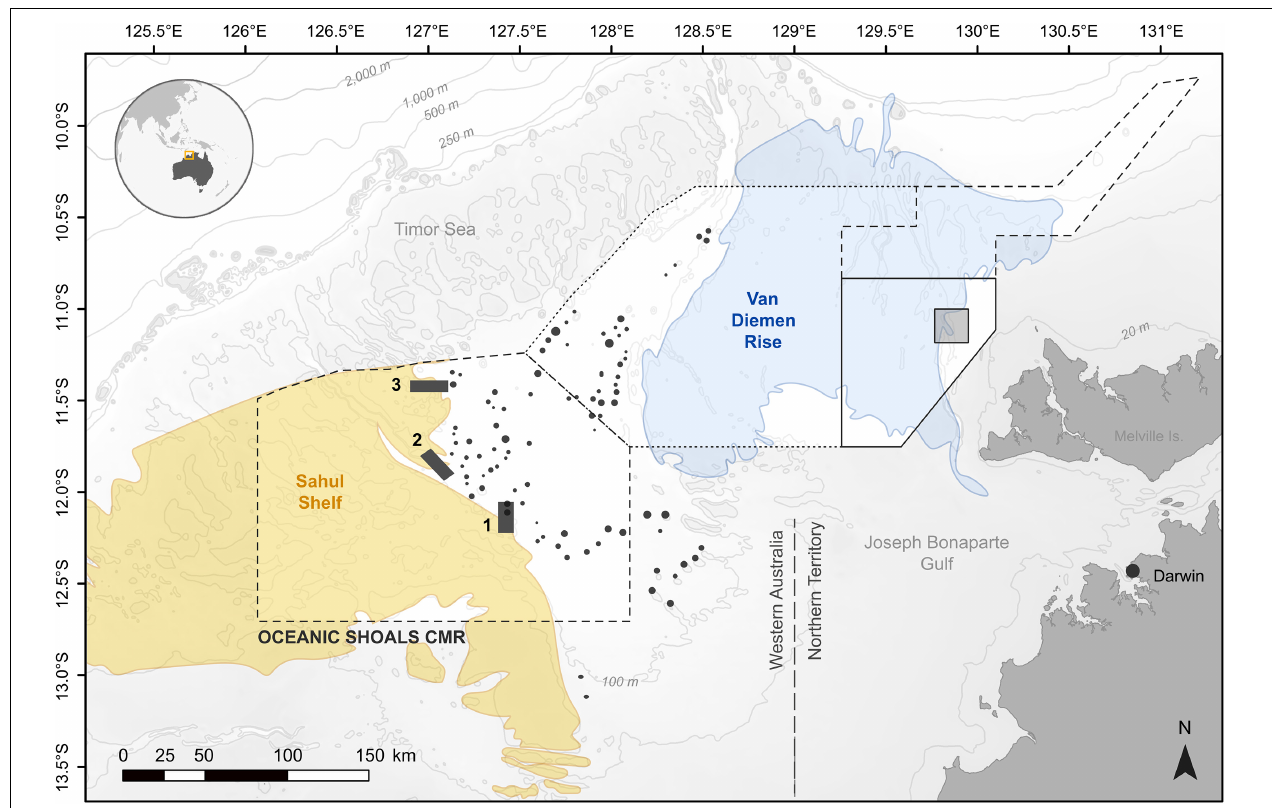
FIGURE 1 | Map of the study region showing the survey areas (numbered 1 to 3) in relation to seabed geomorphology and the boundaries of the Oceanic Shoals Australian Marine Park (AMP). Bathymetry appears in gray, and black circles represent previously known carbonate banks. The AMP comprises four zones, namely a Multiple Use zone (IUCN VI, dashed line), a Special Purpose zone (Trawl) (IUCN VI, dotted line), a Habitat Protection zone (IUCN IV, solid line), and a National Park zone (IUCN II, shaded area). Human activities such as recreational and commercial fishing, mining, aquaculture, or shipping are permissible in the former two zones, whereas mining is prohibited in the Habitat Protection zone, and the National Park zone receives full protection.